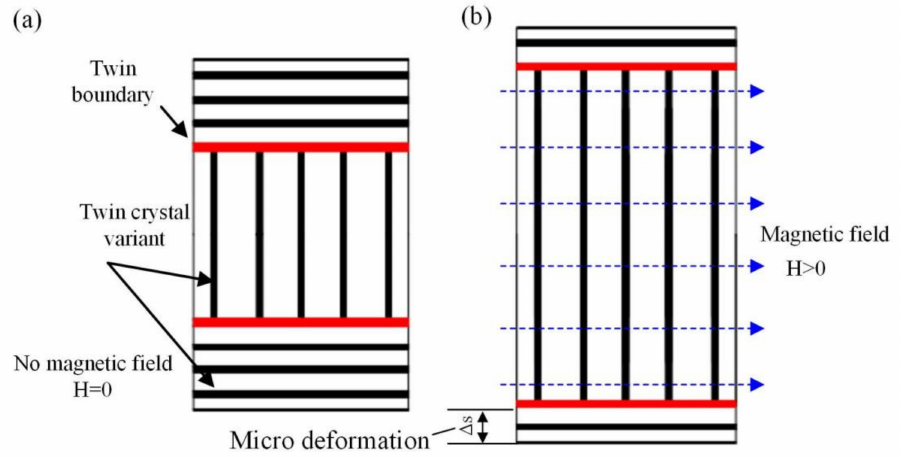
Figure 3. Deformation principles of MSMA: ( a ) the original shape of the MSMA without a magnetic field; ( b ) the strained shape with a magnetic